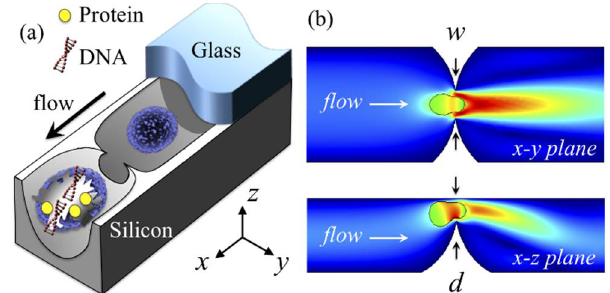
Figure 1. Single-cell point constriction for reagent-free cell lysis. ( a ) 3D rendering: cell being ruptured by the ultra-sharp edge of a round constriction. ( b ) Cutaway views: cell undergoing excessive rapid deformation through a point constriction. Colour spectrum: flow velocity (increasing from blue to red). The glass cover is partially illustrated for clarity.